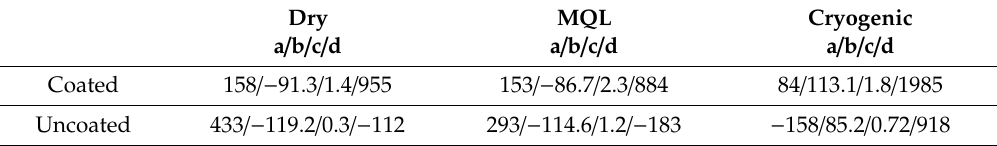
Figure 8. Model prediction of affected layer Al vs. experiments.